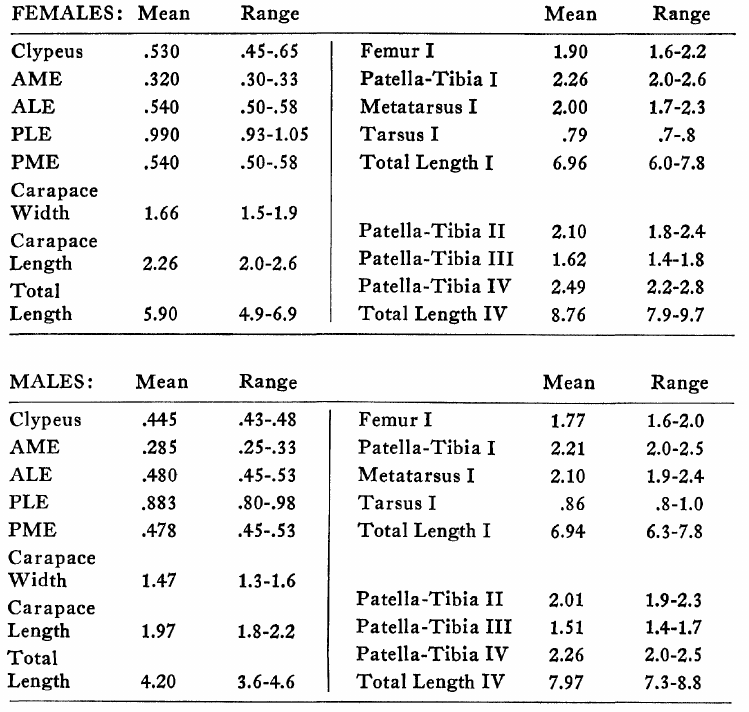
Color. Female. Face and chelicera.e yellow to yellow-orange with faint darker vertical stripes from AME to subdistal region .of cheli- cerae as in Figure 7. Eye nacelles black. Lower edge o,f clypeus lighter, pale